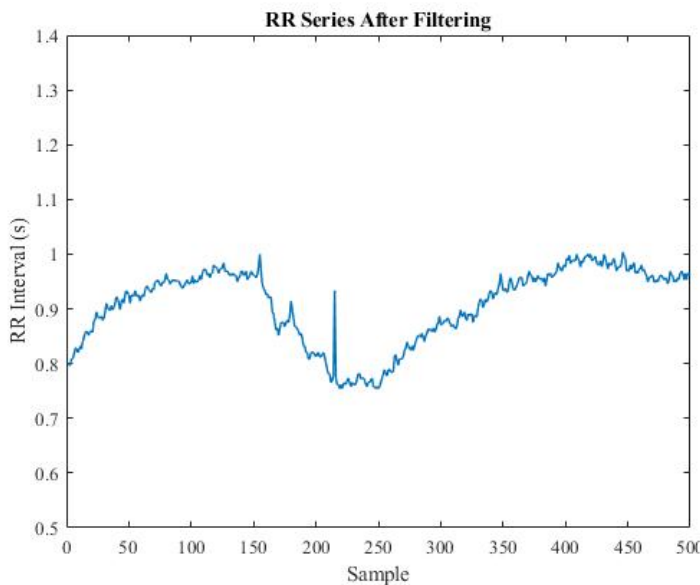
Figure 2. Plot of RR series before filtering.